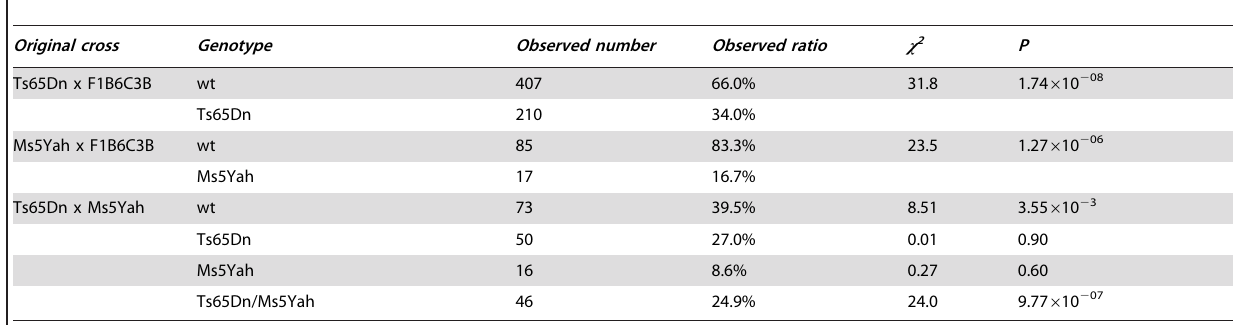
Table 1. Transmission rates of the Ts65Dn and Ms5Yah alleles observed at weaning in Ts65Dn, Ms5Yah, and Ts65Dn/Ms5Yah mice.